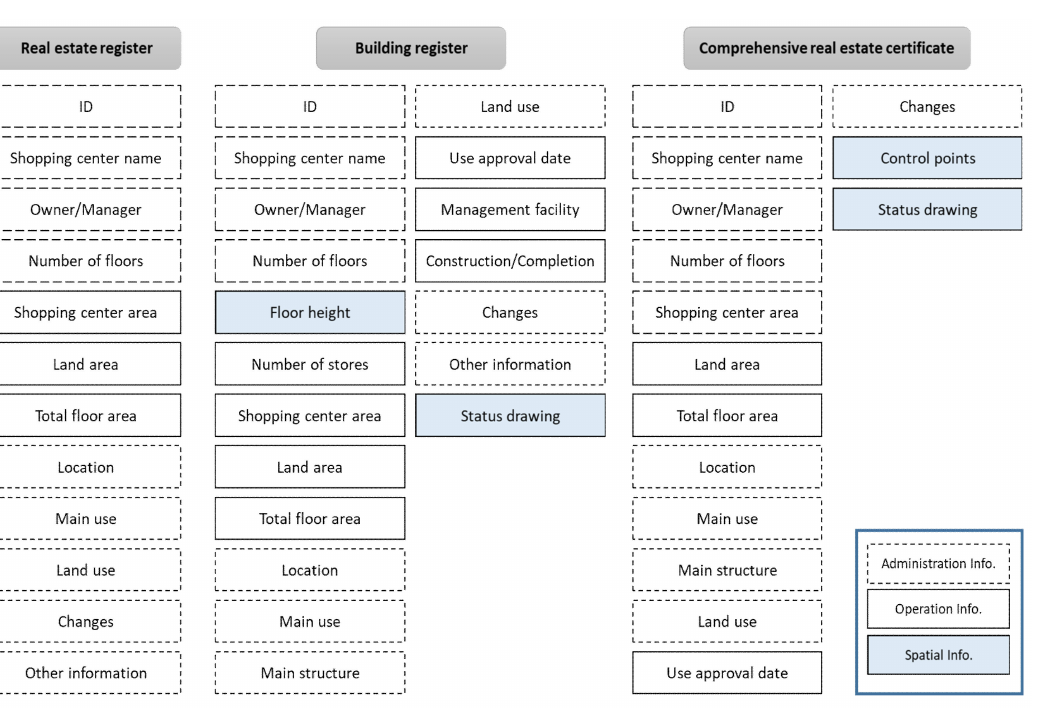
Figure 9. Rights status information generation for underground shopping